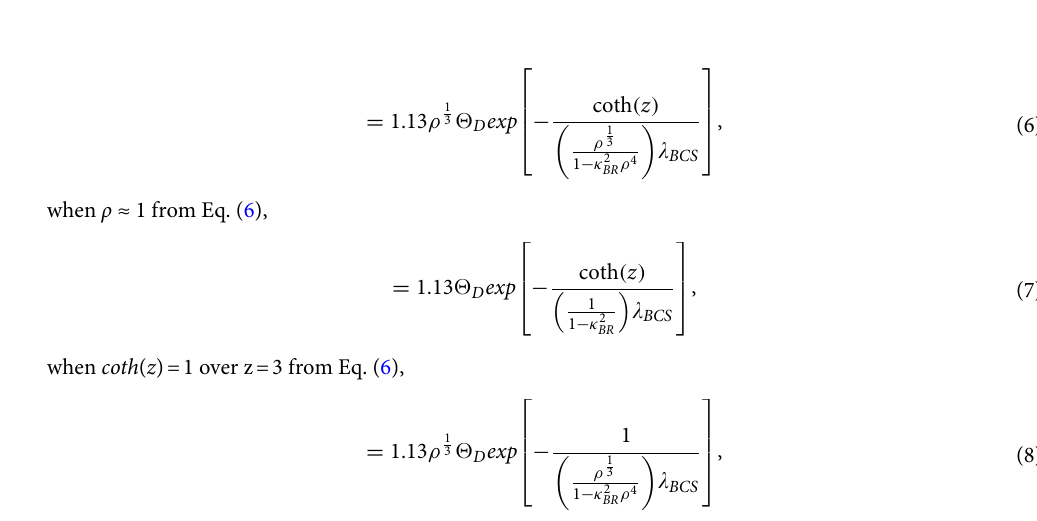
Figure 2. ( a ) A divergence of an effective electron–phonon-coupling constant, λ * = Aλ BCS with λ BCS = 0.03, is shown as a function of band-filling ρ , where A = N (0) * / N (0) = ρ (1/3) /(1 − κ BR 2 ρ 4 ) at κ BR ≈ 1 is a ratio of the 3D density of states, and N (0) is the 3D density of states. The inset displays the divergences of the effective mass, m* / m = 1/(1 − ρ 4 ) 32,33 , and the ratio A . In the inset, the layout of the inhomogeneous mixed phase with a correlated metal ( κ BR ≡ U / U c ≈ 1 (≠ 1)) and insulator phases in the measurement region is also depicted. ( b ) The λ BCS dependence of the BR-BCS T c is shown. Here, the Θ D = 1250 K in Eq. (6) was used. As λ BCS increases, T c increases at a constant ρ . At a constant T c , as λ BCS increases, ρ decreases but λ * does not